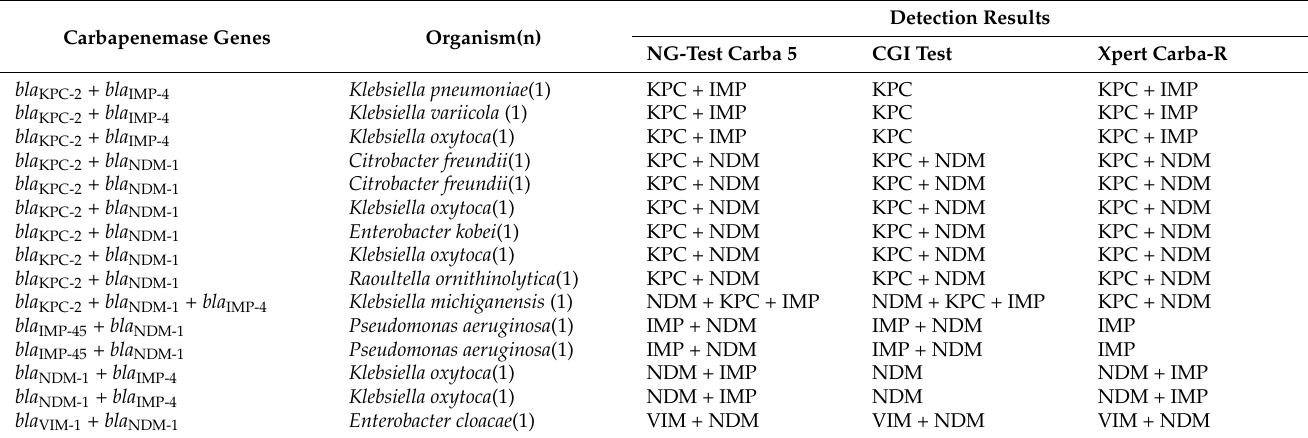
Table 4. Detection results of multi-carbapenemase genes by different